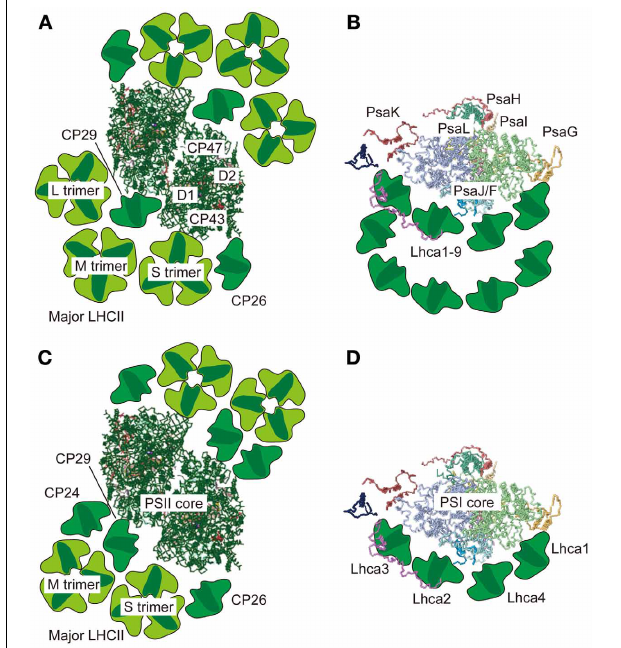
FIGURE 1 | Supramolecular organization of PSII-LHCII and PSI-LHCI supercomplexes in green algae and vascular plants. Top views of the PSII-LHCII supercomplex (A) and the PSI-LHCI supercomplex (B) from C. reinhardtii based on single-particle image analysis by Tokutsu et al. (2012) and Drop et al. (2011), respectively. Top views of the PSII-LHCII supercomplex from spinach (C) and the PSI-LHCI supercomplex from pea (D) based on single-particle image analysis by Dekker and Boekema (2005) and crystallography of the PSI-LHCI supercomplex (Amunts et al., 2010), respectively. All top view images are from the lumenal side. The PSII and PSI core structures were taken from the coordinates determined by crystallography in 3ARC.pdb and 2WSC.pdb,